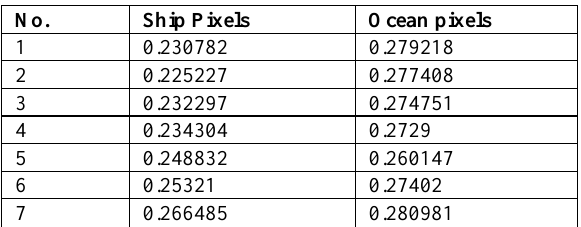
Table 5 ALOS1 Eigenvalue